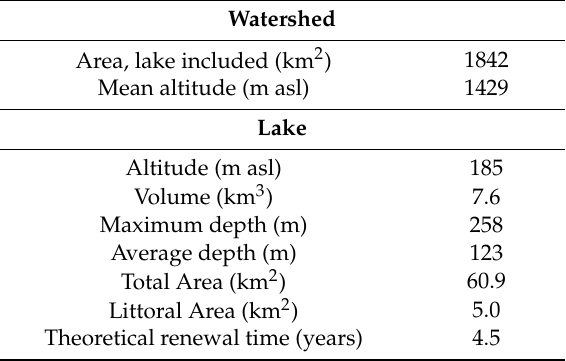
Table 1. Main features of Lake Iseo and its